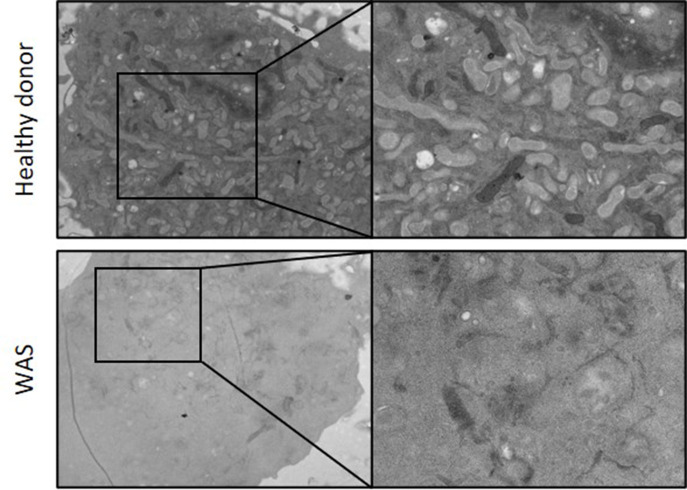
WASp is necessary for autophagosome formation.Healthy donor and WAS MDMs cultured in complete RPMI and analysed by electron microscopy.